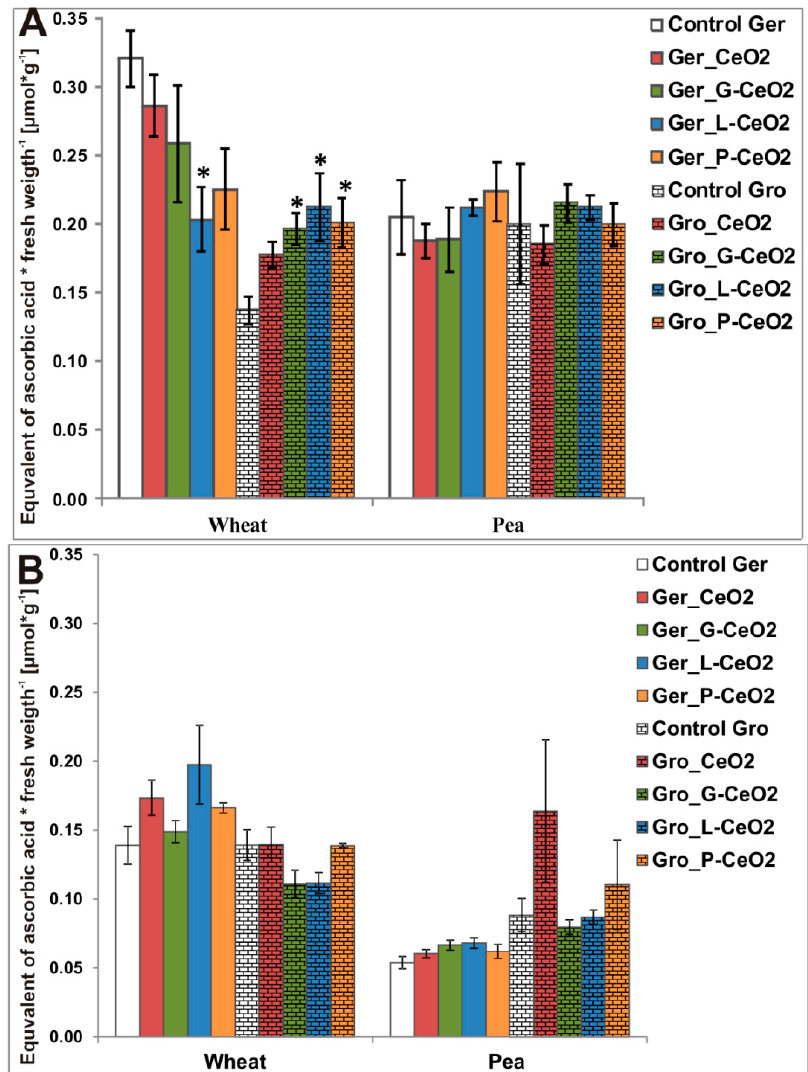
Figure 5. Effect of different nCeO 2 on total antioxidative activity (TAA) in wheat and pea Figure 5. E ff ect of di ff erent nCeO 2 on total antioxidative activity (TAA) in wheat and pea shoots ( A ) shoots ( A ) and roots ( B ) after Ger and Gro treatment. Values are shown as mean ± SE; * and roots ( B ) after Ger and Gro treatment. Values are shown as mean ± SE; * indicates statistically indicates statistically significant differences in comparison with the corresponding control, p significant di ff erences in comparison with the corresponding control, p < < 0.05.